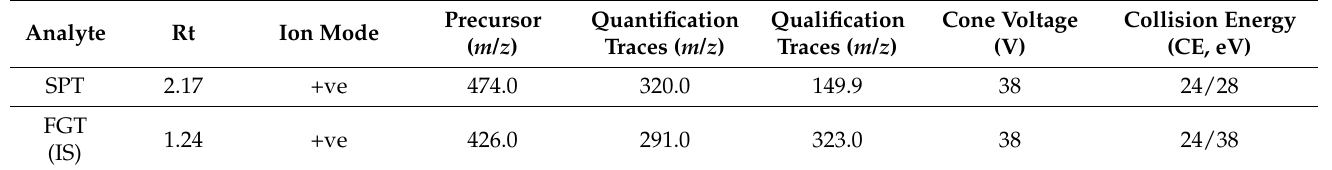
Table 6. MRM parameters for the determination of SPT and FGT